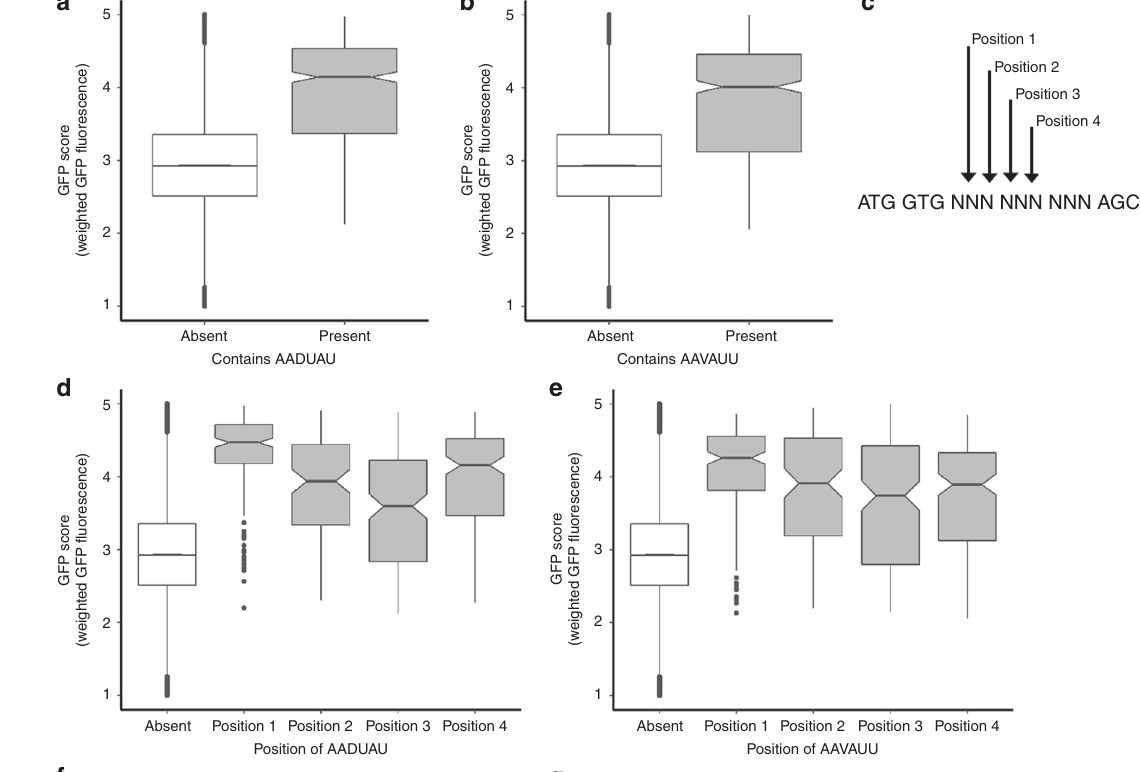
Codons 3 and 4 for motifs AADTAT and AAVATT